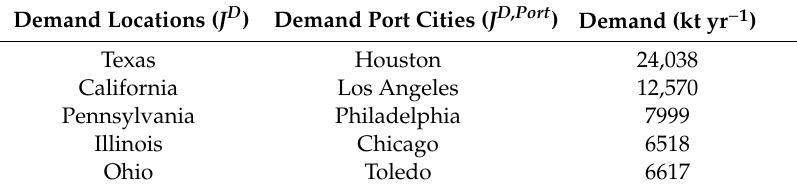
Table 5. Demand locations for the United States case of the algal biomass to biodiesel problem.